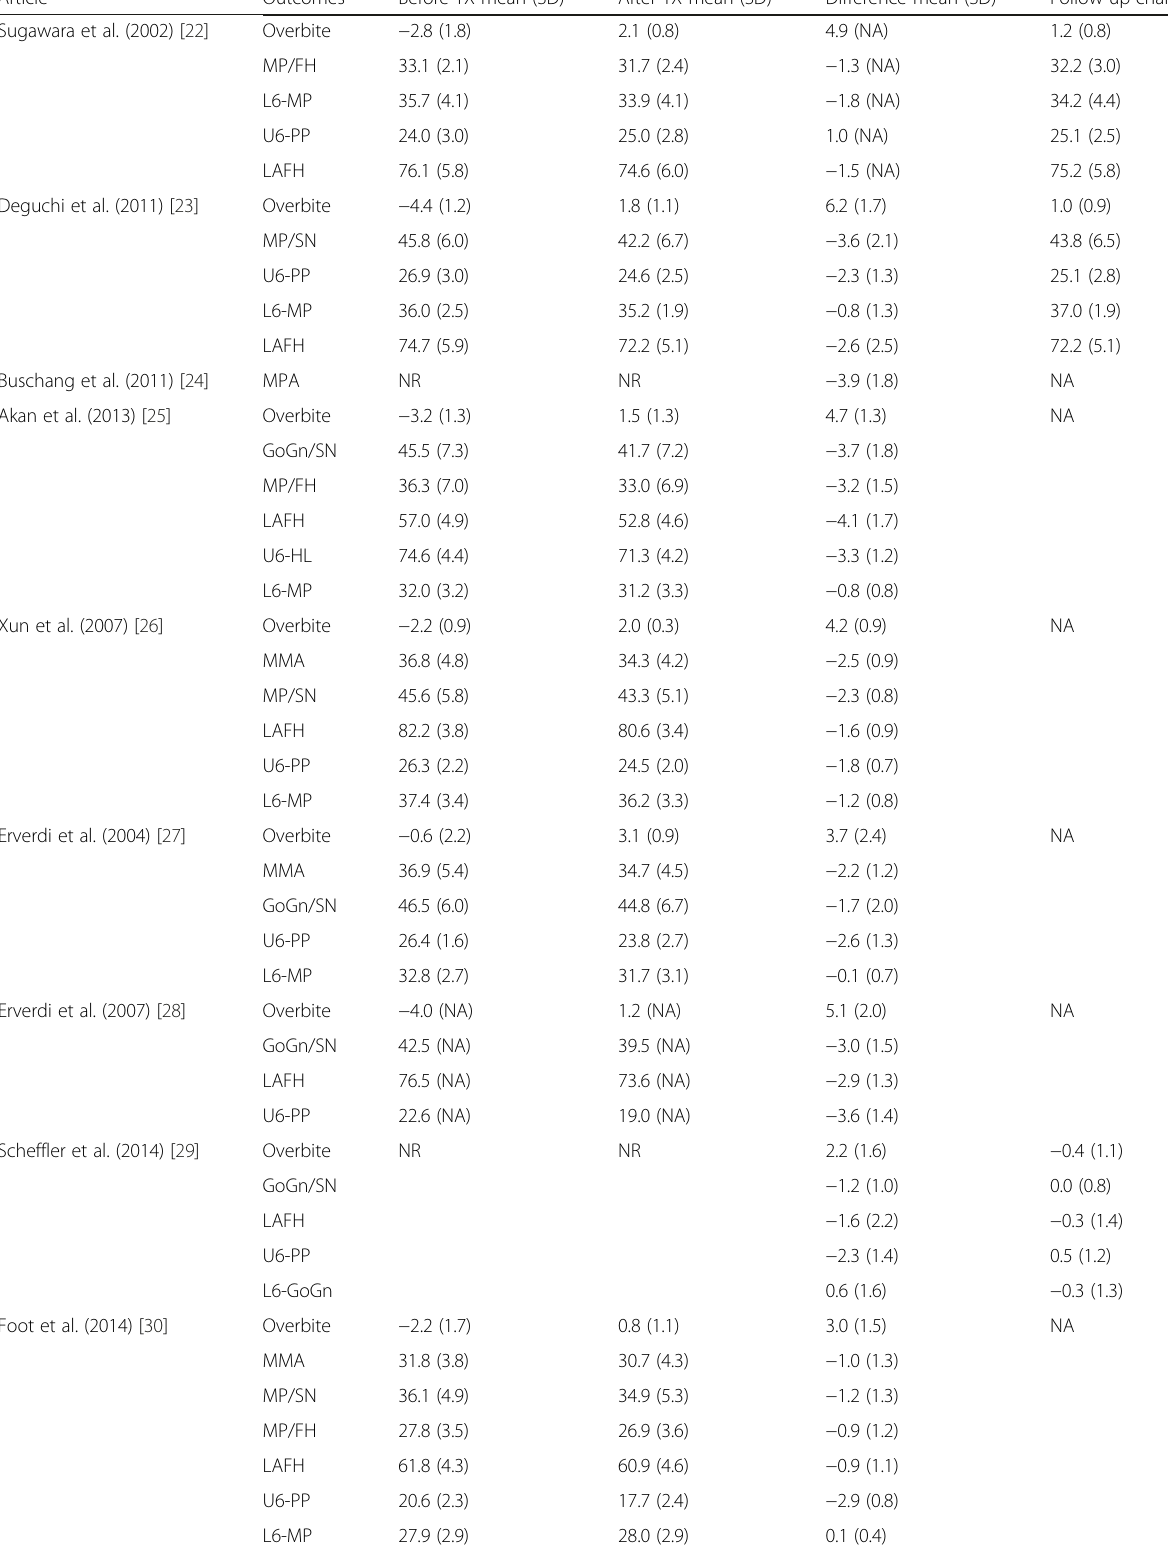
Table 4 Summary of outcome measurements of the selected studies